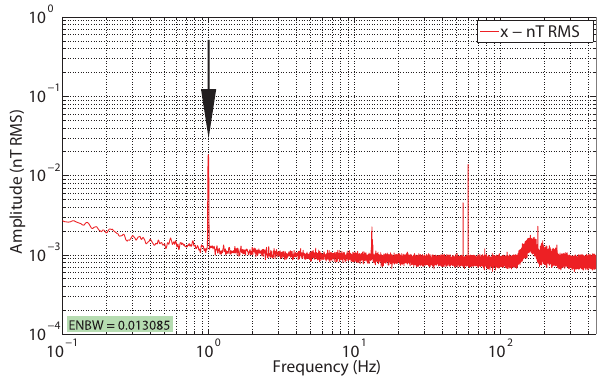
Fig. 10. Amplitude spectrum showing resolution of prototype in- strument. Arrow shows an 18pT RMS sinusoidal test signal at